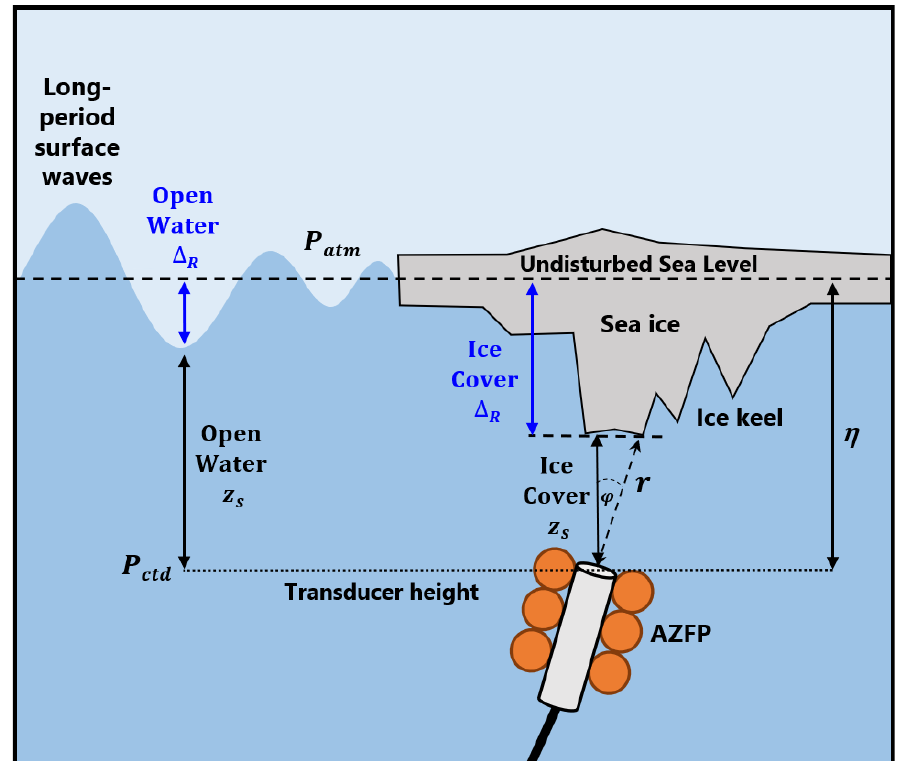
Figure 2. Diagram of the terms used to calculate ∆ R from AZFP data. Note that the long-period surface waves (e.g., tide waves, shelf waves) depicted in the figure do not include short ‐ period surface capillary waves, wind waves, or swell.